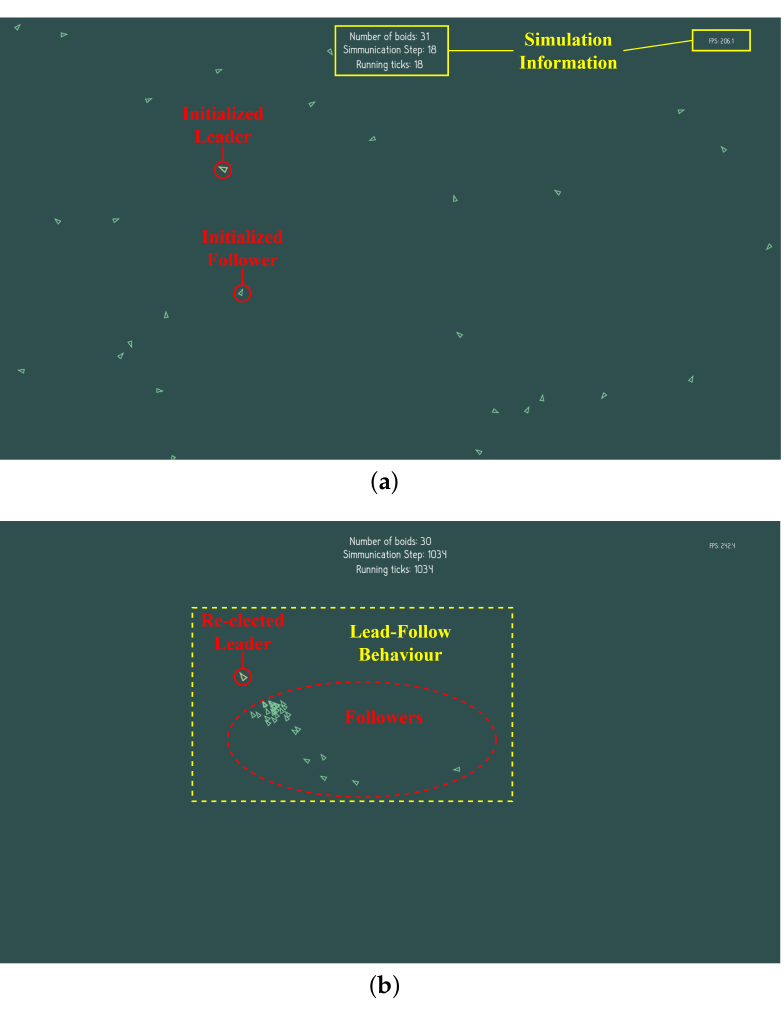
Figure 7. An overview of simulation environment setup. ( a ) Initialization of experiments. ( b ) Lead- Follow behavior of